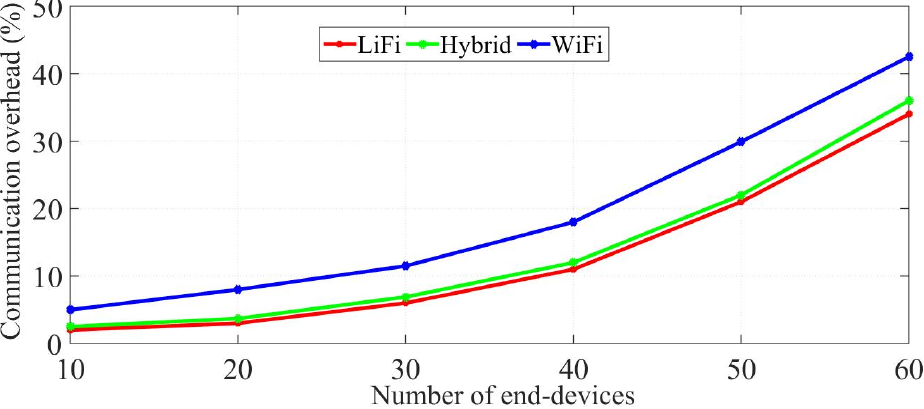
Figure 6. Communication overhead of the three considered systems for different numbers of end devices.